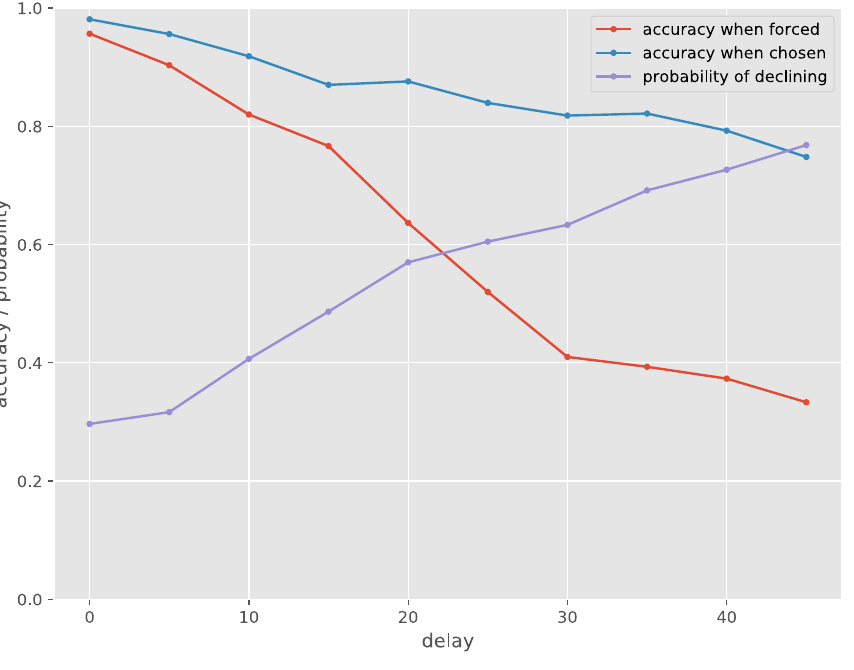
Figure 8. Behavior of the evolved agent for each delay